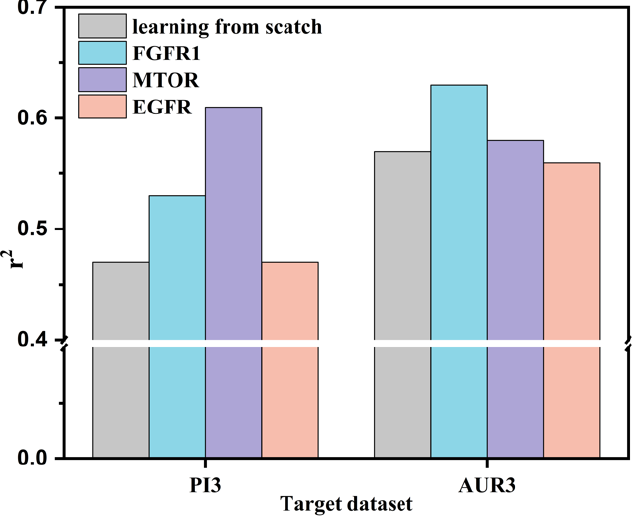
Figure 2. Transfer learning results for PI3 and AUR3 as target datasets and FGFR1, MOTR, and EGFR as source datasets, learning from scratch as the baseline to evaluate the improvement.